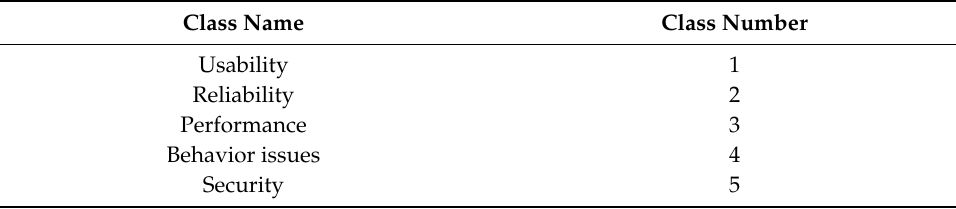
Table 3. Mobile apps issues—classes.